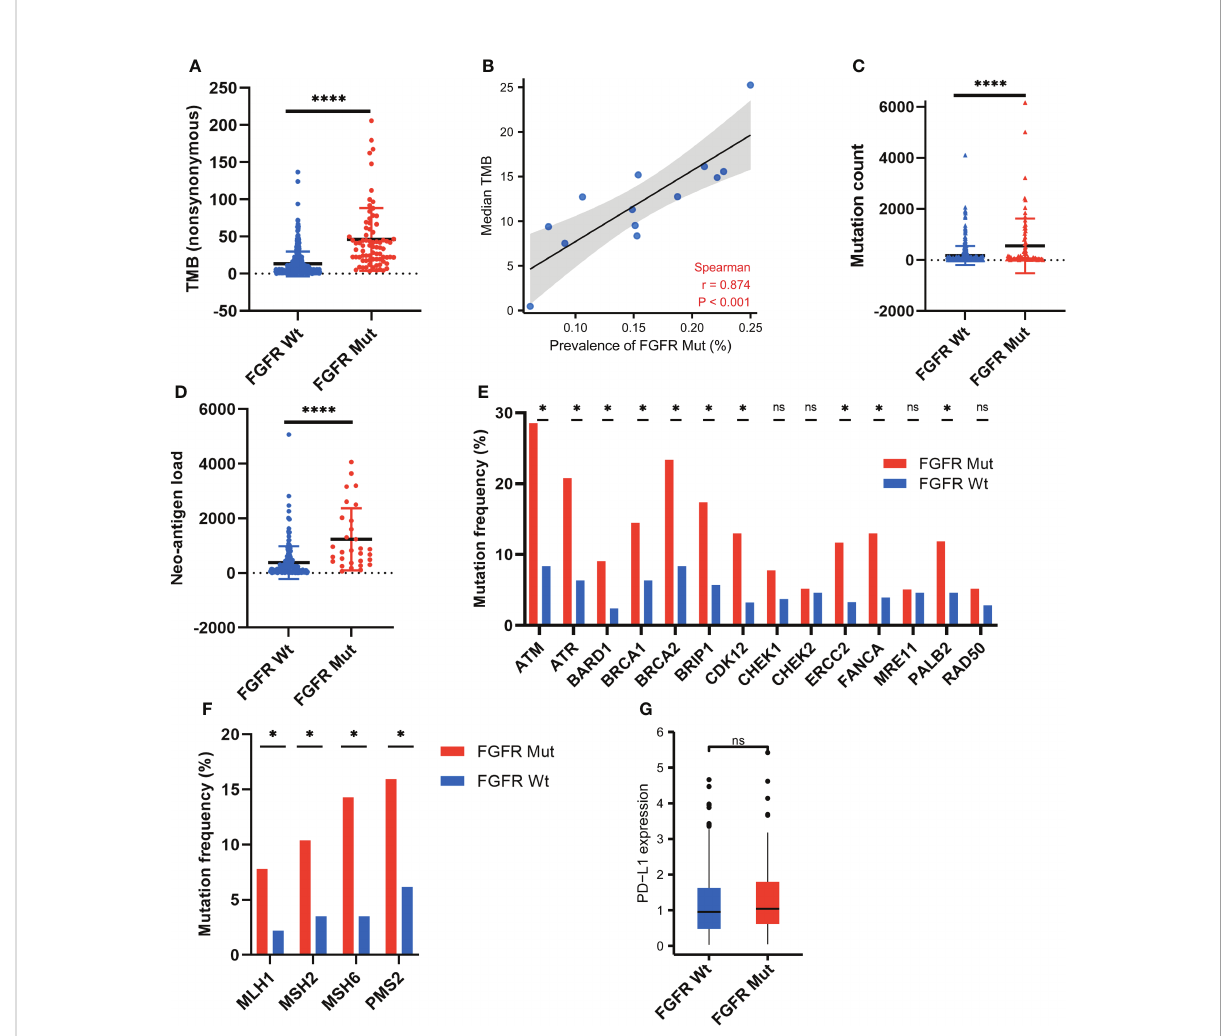
FIGURE 6 Association of FGFR mutations with parameters involving immunogenicity. (A) Comparison of TMB between FGFR Mut and FGFR Wt melanoma in ICIs-cohort. (B) Correlation of FGFR mutation frequency with median TMB in 13 melanoma studies. (C) Comparison of mutation count between FGFR Mut and FGFR Wt melanoma in ICIs-cohort. (D) Comparison of neo-antigen burden between FGFR Mut and FGFR Wt melanoma in ICIs-cohort. (E) Comparison of DDR-related gene mutations between FGFR Mut and FGFR Wt melanoma in ICIs-cohort. (F) Comparison of MMR-related gene mutations between FGFR Mut and FGFR Wt melanoma in ICIs-cohort. (G) Comparison of PD-L1 expression between FGFR Mut and FGFR Wt melanoma using TCGA data (ns = not signi fi cant, *P < 0.05, ****P <